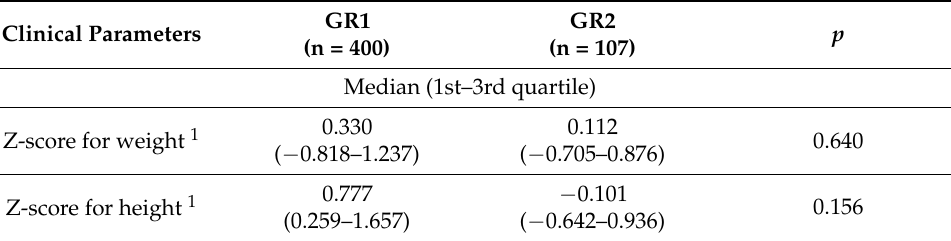
Table 4. Body weight and height deviations in the study